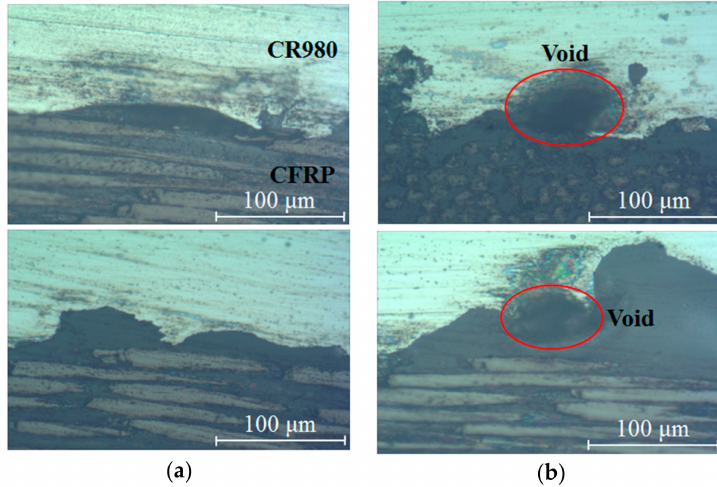
Figure 10. Microstructures (section view) CFRP/CR980 hybrid composites conducted by shear lap adhesion test: ( a ) surface roughness Rz = 45 µ m; ( b ) surface roughness Rz = 60 µ